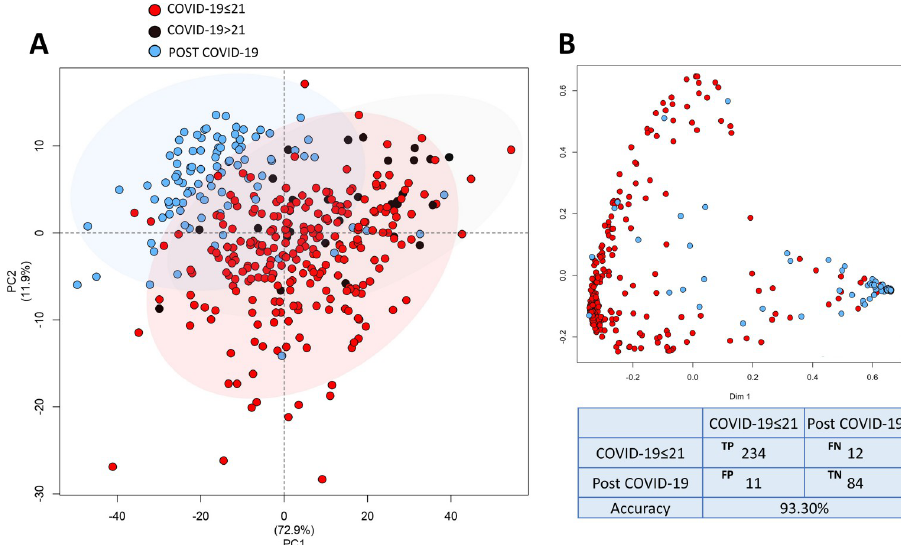
Fig 2. Multivariate statistics. A) Score plot of PCA analysis. Ellipsis indicate the 95% confidence intervals. B) Proximity plot of the RF model discriminating COVID-19 � 21 patients and Post COVID-19 subjects with confusion matrix and accuracy value. In the confusion matrix, TP means true positive, FP false positive, TN true negative and FN false negative. Red dots: COVID-19 � 21; black dots: COVID-19 > 21; blue dots: Post